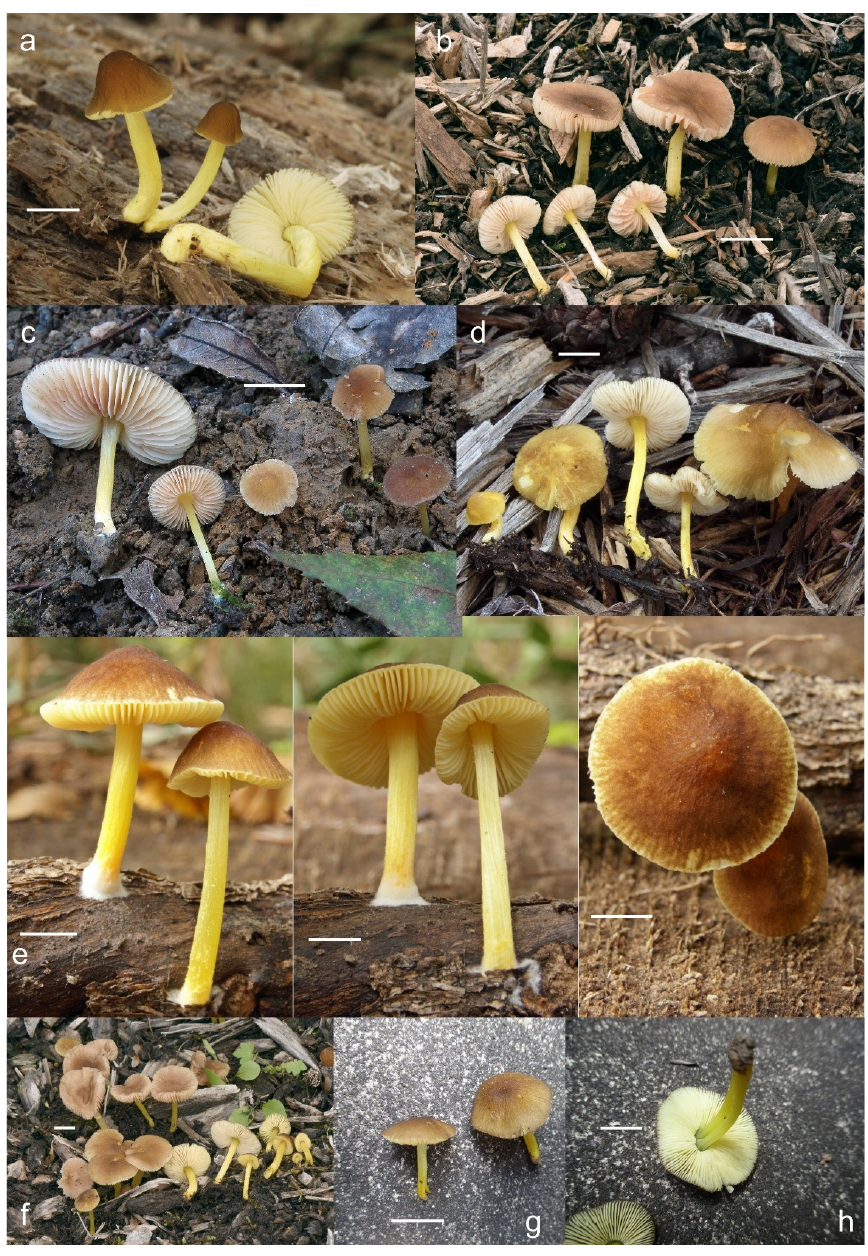
Figure 14. Pluteus vellingae basidiomata in situ: ( a ). HRL1462, ( b ). HRL3635, ( c ). GM 3260, ( d ). FG 23281, ( e ). FG 13772-17433, ( f ). HRL3646, ( g , h ). Mushroom Observer 281889 (photos by Dave Wasilewski). Scale bars 1 cm.